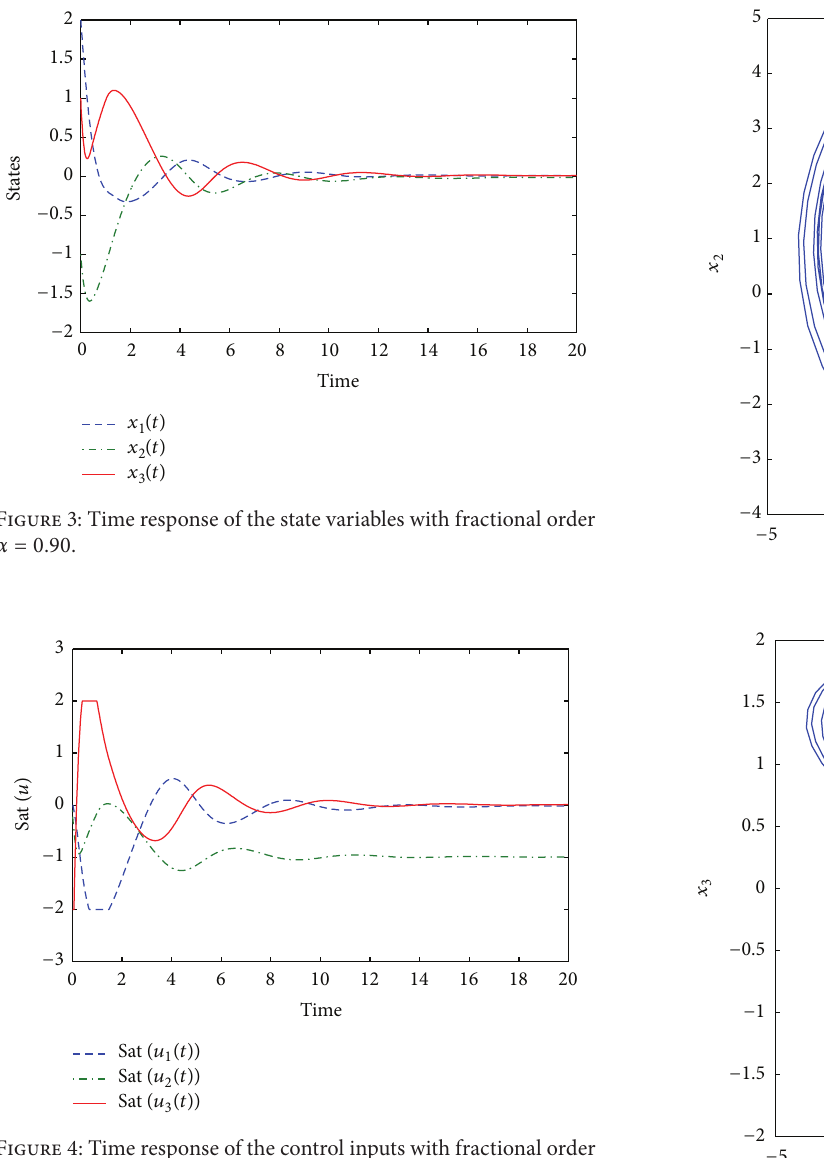
Figure 4: Time response of the control inputs with fractional order 𝛼 = 0.90 .